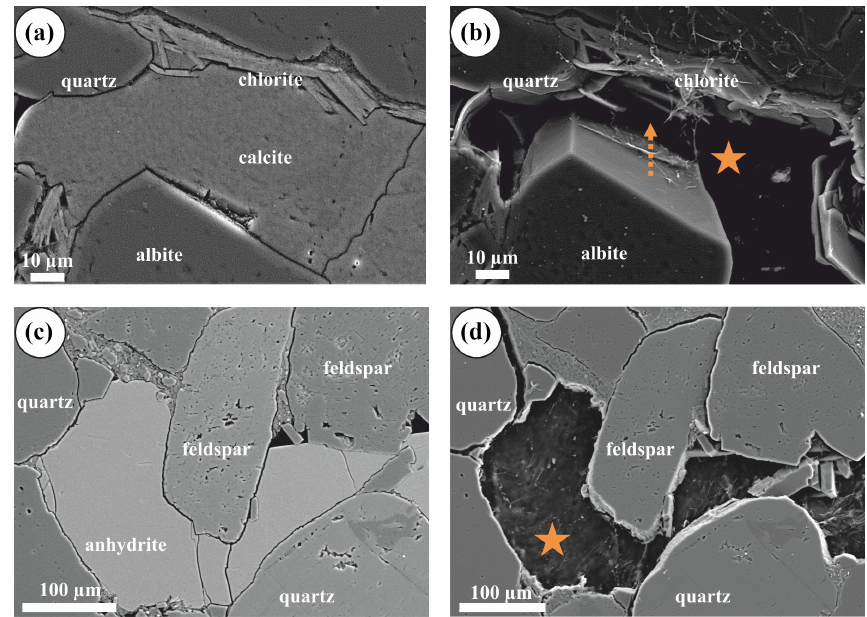
Figure 9. Secondary electron FE-SEM images of the same section of a Permian sandstone sample before (a, c) and after (b, d) CO 2 experiments under reservoir conditions for seven weeks. The dissolution of pore-filling calcite cement (star in b ) and the exposure of grain rimming clay minerals (arrow in b ) led to increasing porosity outcomes after the CO 2 experiments and the increase of the specific surface area (modified after Henkel et al., 2014). In (c) and (d) the dissolution of pore-filling anhydrite cement (star in d ) is shown at exactly the same thin-section position before (c) and after (d) the CO 2 experiments, also leading to increasing porosity values after the